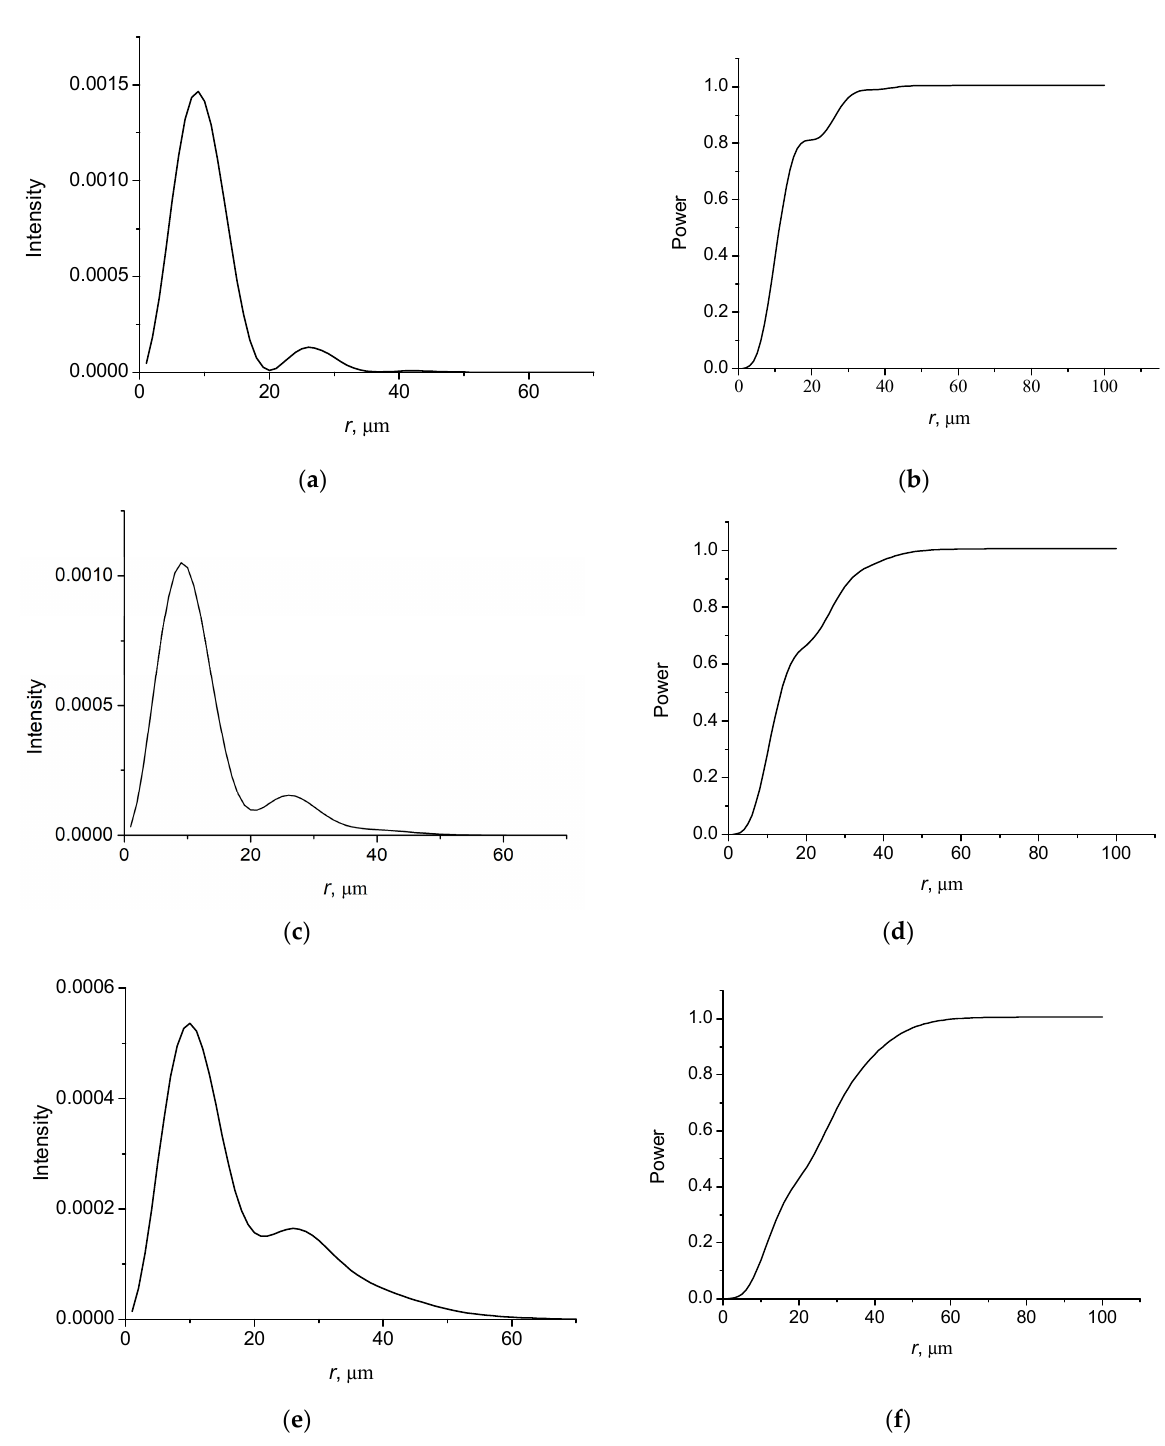
Figure 4. Intensity distributions of BG vortex beam with l = 1. w 0 = 30 µ m, w B = 20 µ m, λ = 0.63 µ m. ( a , b ) z = 0; ( c , d ) z = 500 µm; ( e , f ) z = 1000 µm.